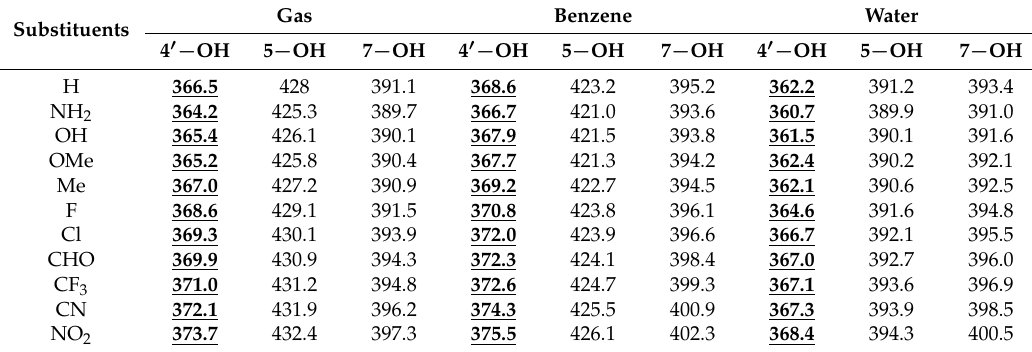
Table 1. O–H bond dissociation enthalpy (BDE) in kJ/mol obtained by the M062X/6-311+G ** method. The data in the form of the bold and underline represent the lowest BDEs in the molecule. Gas Substituents